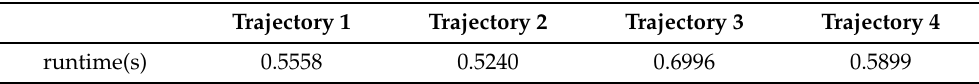
Table 3. Averaged runtimes for four